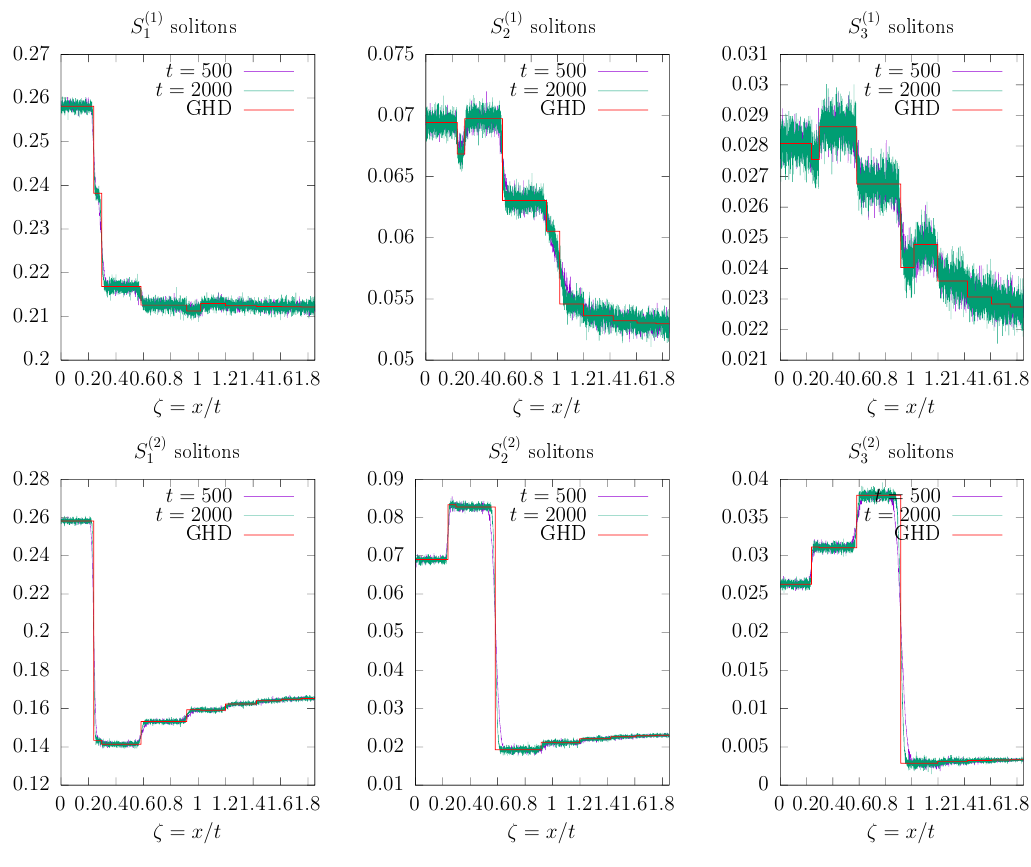
( a ) Figure 3: Numerical results for several S -soliton densities (with sizes k = 1 , 2 , 3 k and ‘color’ a = 1 , 2 ) as a function of ζ = x/t for t = 500 and t = 2000 and for (1) the T dynamics. The red line indicates the GHD prediction for t = . The l =100 ∞ initial state is defined by the following fugacities in the left half: z 1 ,L = 1 z 2 ,L = 0 . 7 and z 3 ,L = 0 . 3 , and the following fugacities in the right: z 1 ,R = 1 z 2 ,R = 0 . 9 and z 3 ,R = 0 . 1 Parameters of the simulations: system size L = 640000 and number of = 200000 random initial conditions N samples